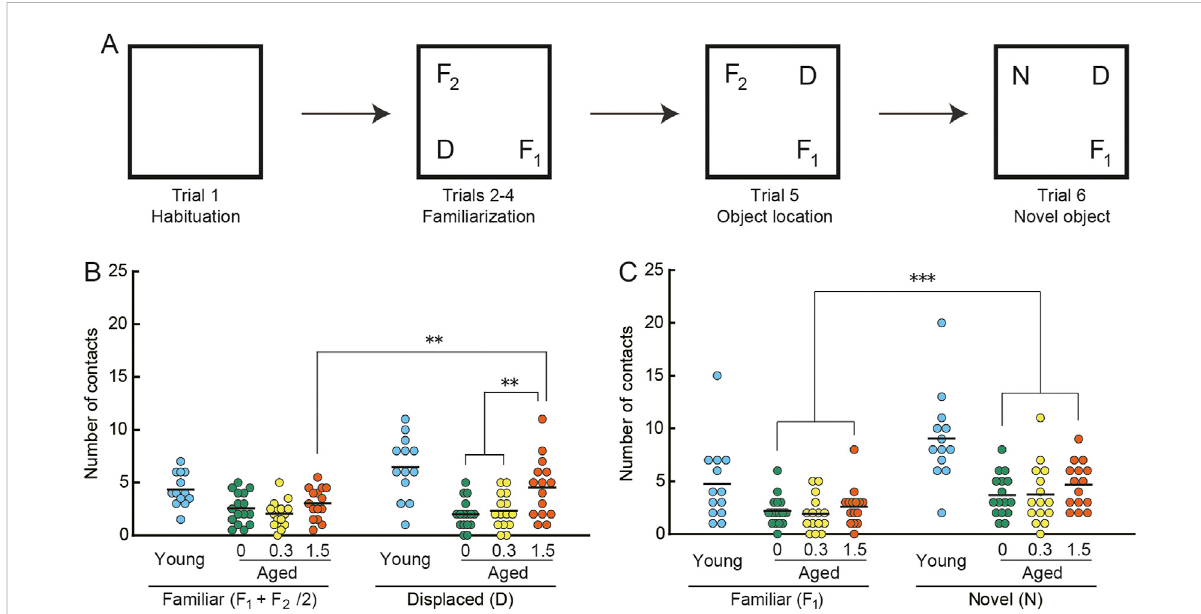
FIGURE 4 Cilostazol improves novel recognition memory in aged mice. (A) Schematic diagram of object recognition task and apparatus. After the mouse habituatedintheemptyarena(Trial1)andbecamefamiliarwiththethreeobjects(F 1 ,F 2 ,D)placedinthearena(Trials2 – 4),itwasconsecutivelytested fi rst on the object location test (Trial 5), in which one of the familiar objects (D) was displaced, and then on the novel object test (Trial 6), in which a familiar object (F 2 ) was replaced by a novel (N) one. Statistical differences among groups were determined by two-way ANOVA. (B) Scatter dot plot representing number of contacts in the spatial change test (Trial5). Among the three groups of aged mice, only the 1.5% cilostazol group made more contacts with the displaced object than with the familiar objects, showing a signi fi cant preference toward the displaced object ( p < 0.01). (C) Scatter dot plot representing number of contacts in the object change test (Trial 6). Mice of the three dose groups intensively explored the novel object ( p < 0.001). However, there were no signi fi cant differences among the three groups. For panels B and C, 0, 0.3, and 1.5 represent the concentration (percentage) of orally administered cilostazol. Performance of 3-month-old young mice (Young) is shown as a reference but not included in statistical analyses. *** p < 0.001, ** p < 0.01. Horizontal bars indicate mean